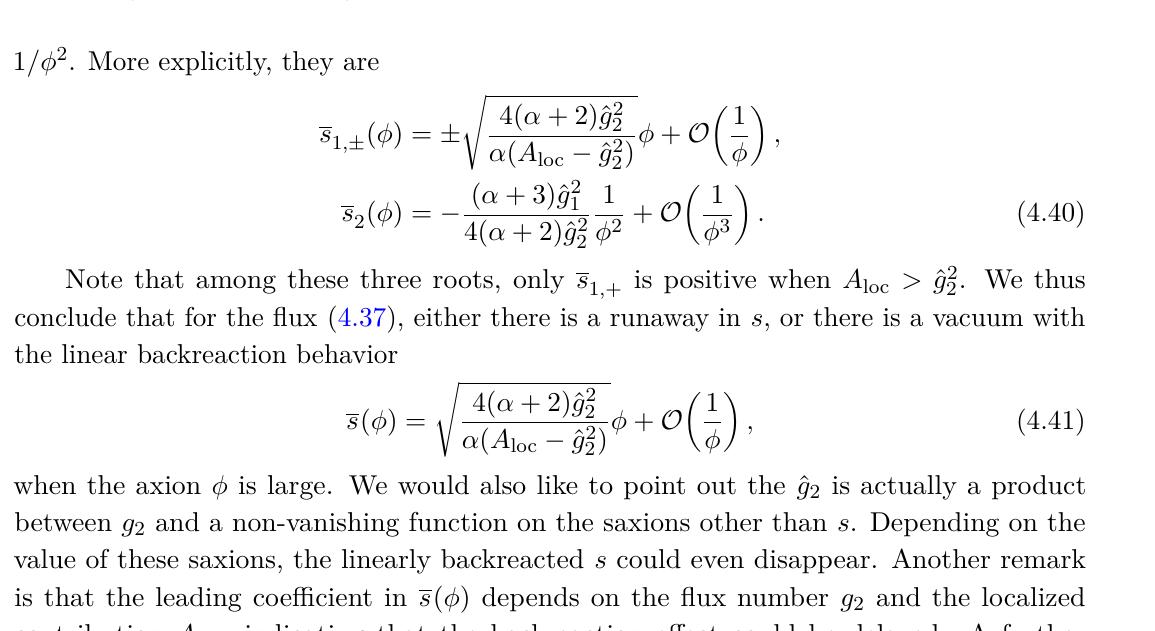
Figure 4 . The Newton polygon of (4.39). It has a segment generating backreaction s ∼ cφ and another segment corresponding to s ∼ cφ − 2